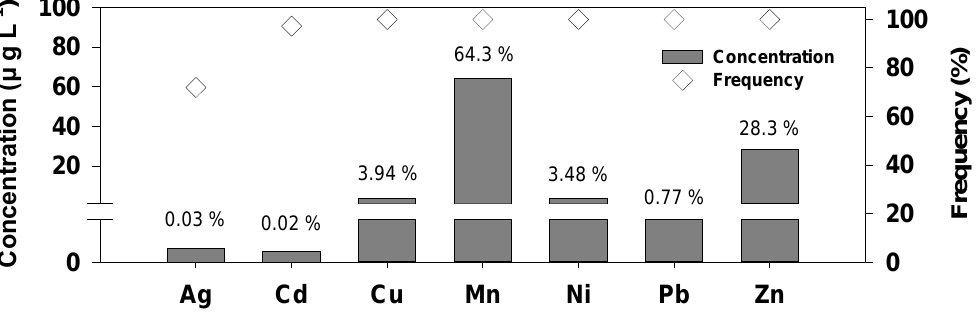
Figure 2. Total concentrations and detection frequencies of heavy metals in the Han River watershed.